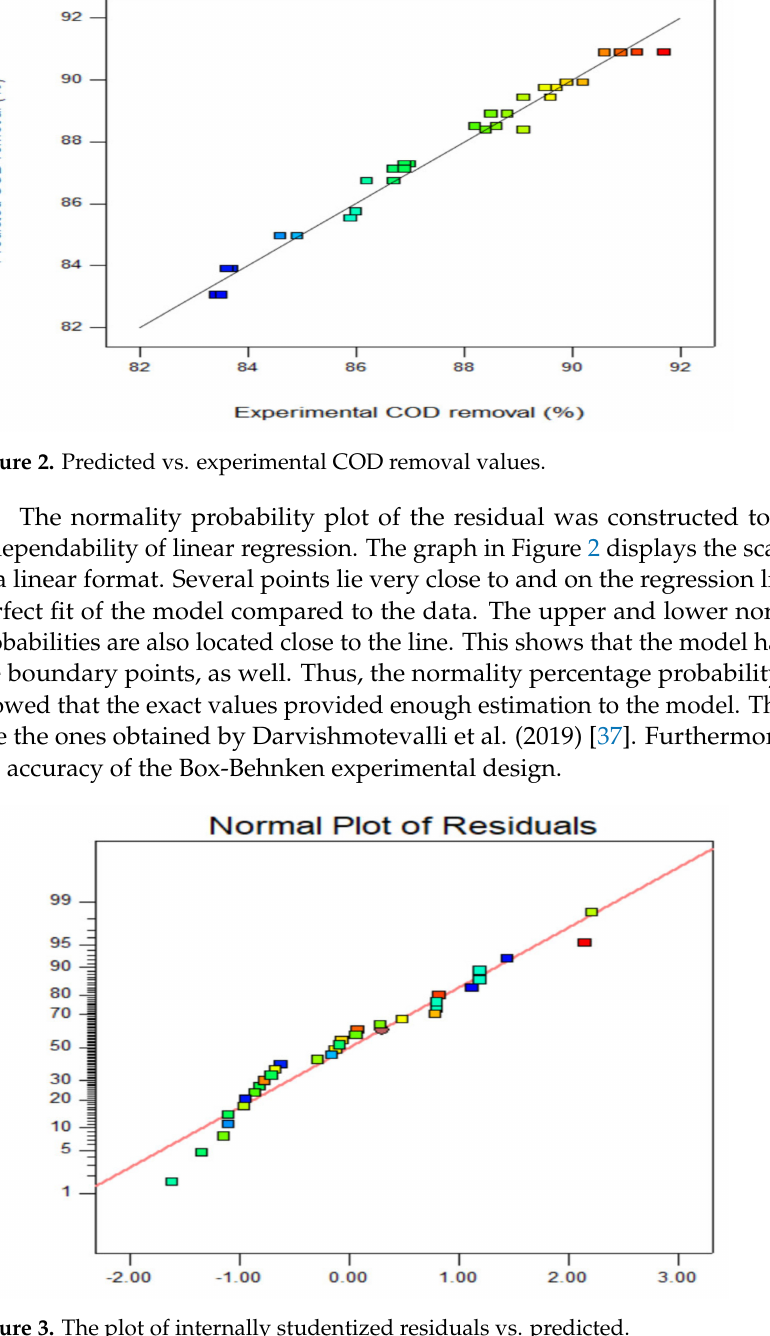
Figure 3. The plot of internally studentized residuals vs.